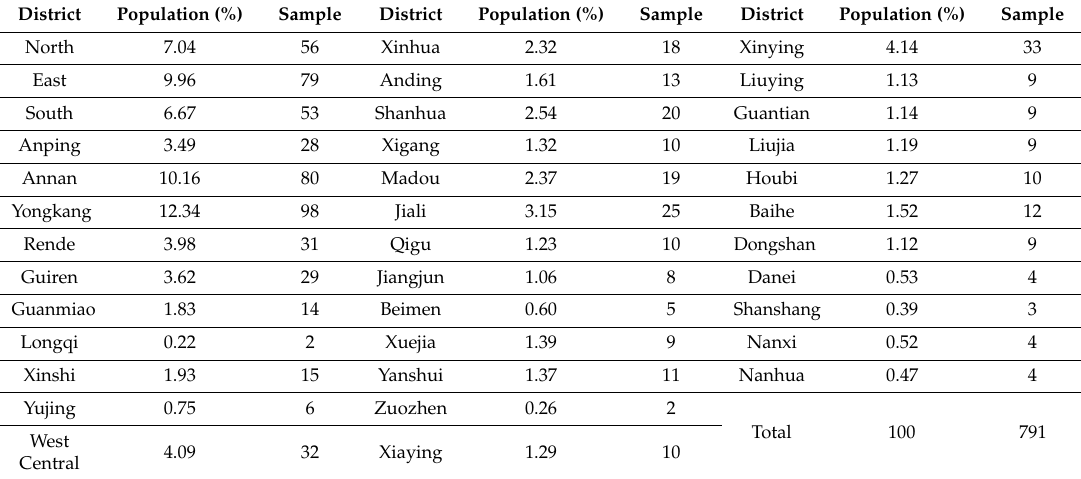
Table 2. Number of sample distributions by